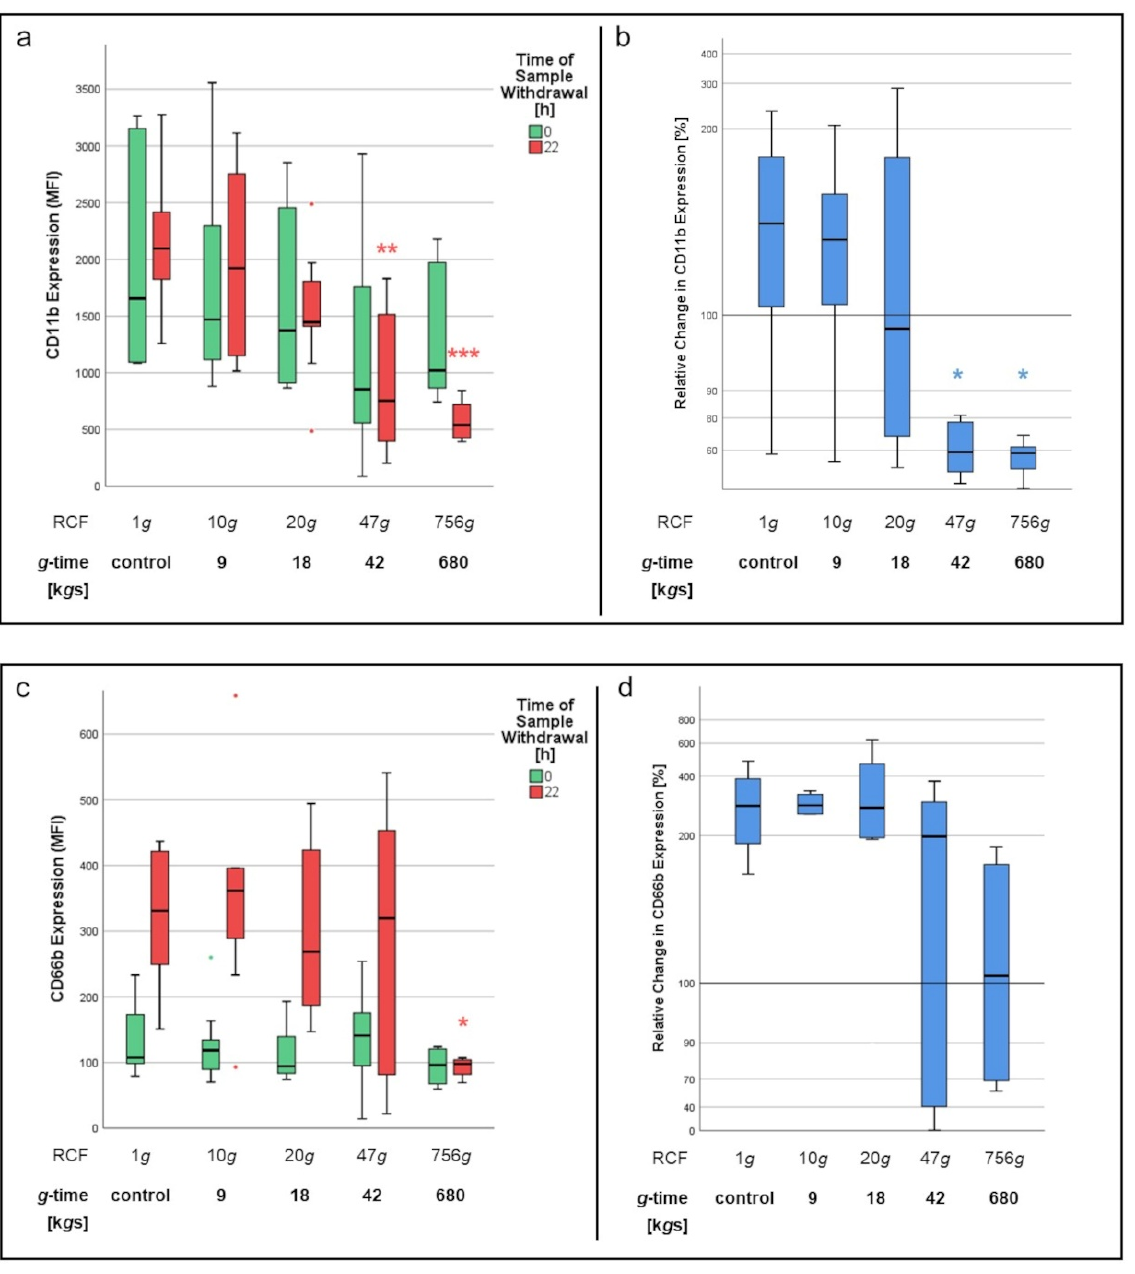
Figure 10. Expression of surface antigens CD11b ( a , b ) and CD66b ( c , d ) before (t = 0) and after (t = 22) incubation with fMLP. Significant differences (* p < 0.05; ** p < 0.01; *** p < 0.001) are determined as compared to the 1 g control at the same time of measurement. Colorings indicate the time of sample withdrawal. In ( b , d ), expression levels at t = 0 were determined as a relative change value = 100. Therefore, relative change values of >100 indicate increased expression at t = 22, whereas values of <100 indicate decreased expression at t = 22.